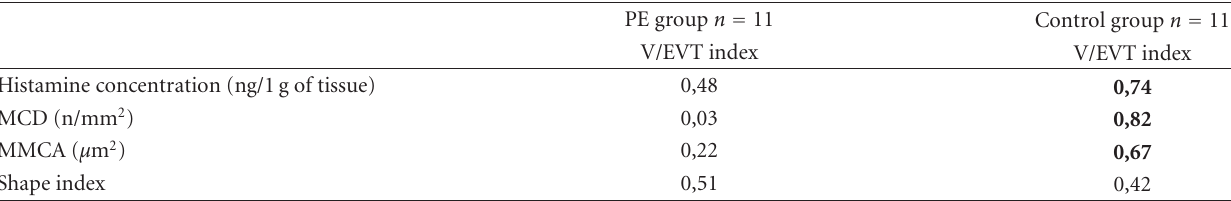
Table 3: The indexes of correlation between histamine concentration and morphometric parameters of mast cells and V/EVT index in each group. V/EVT index: vascular/extravascular tissue index, MCD: mast cell density, MMCA: mean mast cell area. The statistically significant results are in